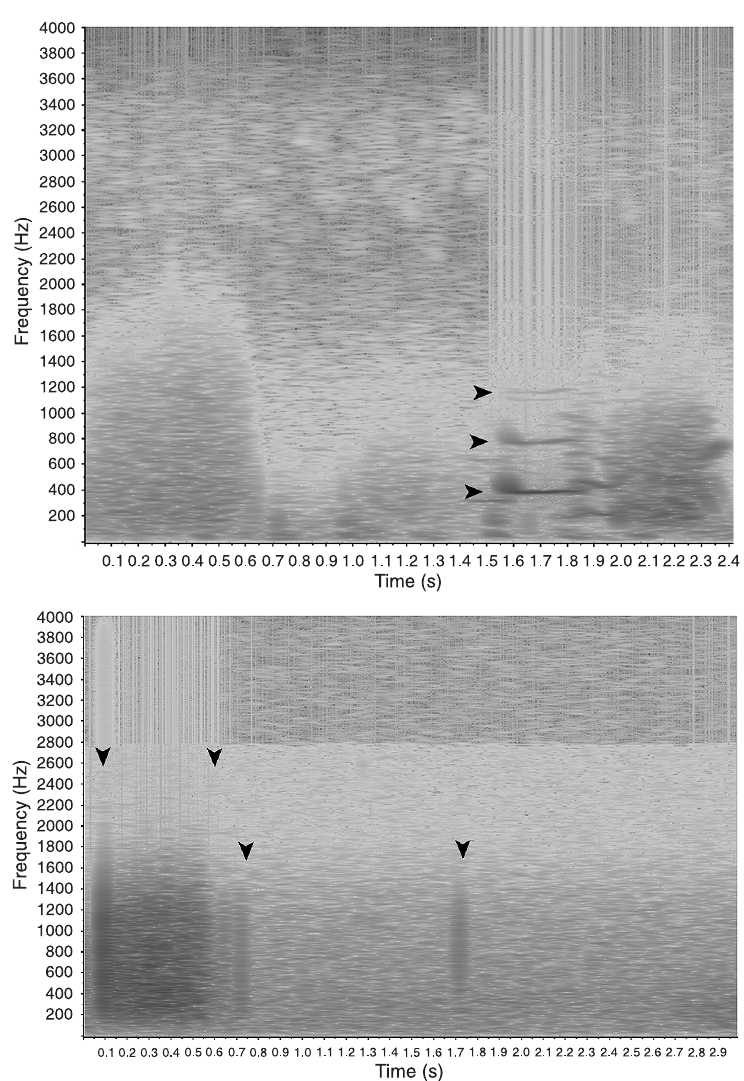
Figure 3. Spectrogram resulting from a bron- chial respiratory cycle with wheezing. The hori- zontal lines in the middle-end (arrowheads) show the appearance of strong frequency components characterizing the presence of wheezes.